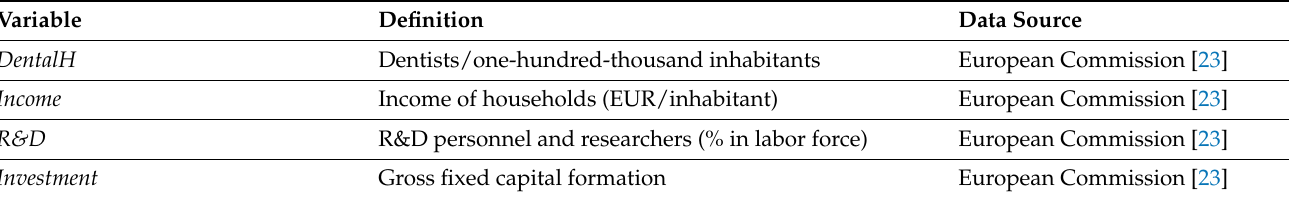
Table 1. The variables included in the analysis.